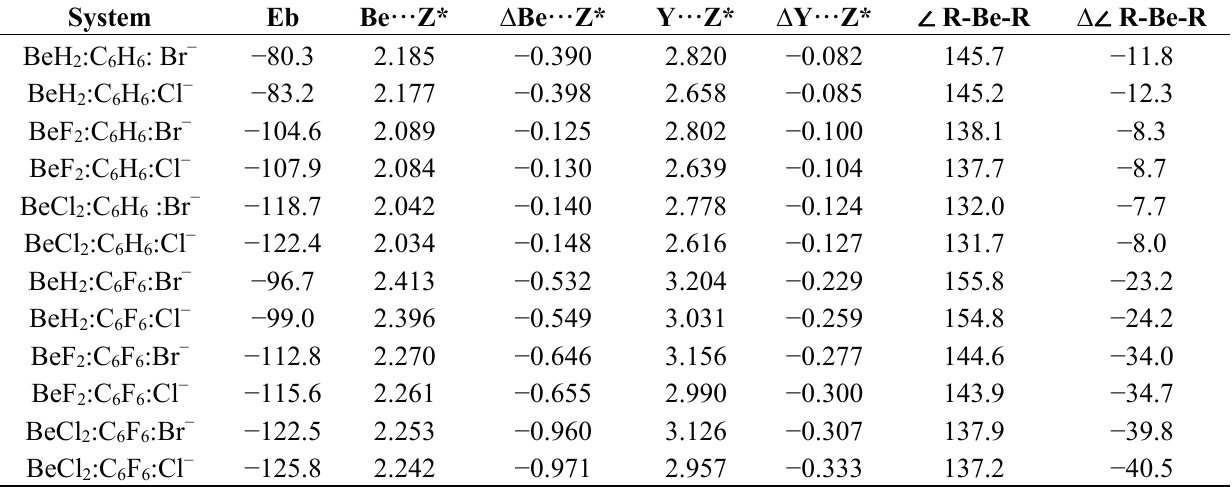
Table 6. Binding energy (kJ/mol), intermolecular distances (Å) and R-Be-R bond angle (°) of the ternary complexes. The variations with respect to the corresponding binary complexes are also